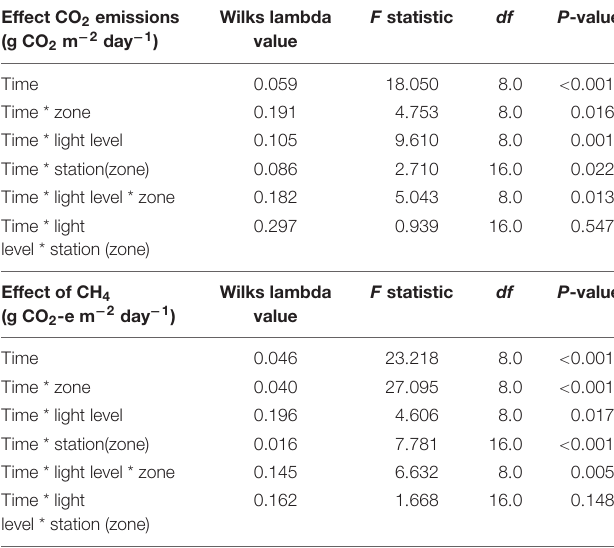
TABLE 1 | Testing the influence of each main factor [zone, light level (day/night), station (zone)] and their interactions against each carbon emission (CO 2 and CH 4 ) across the environmental watering